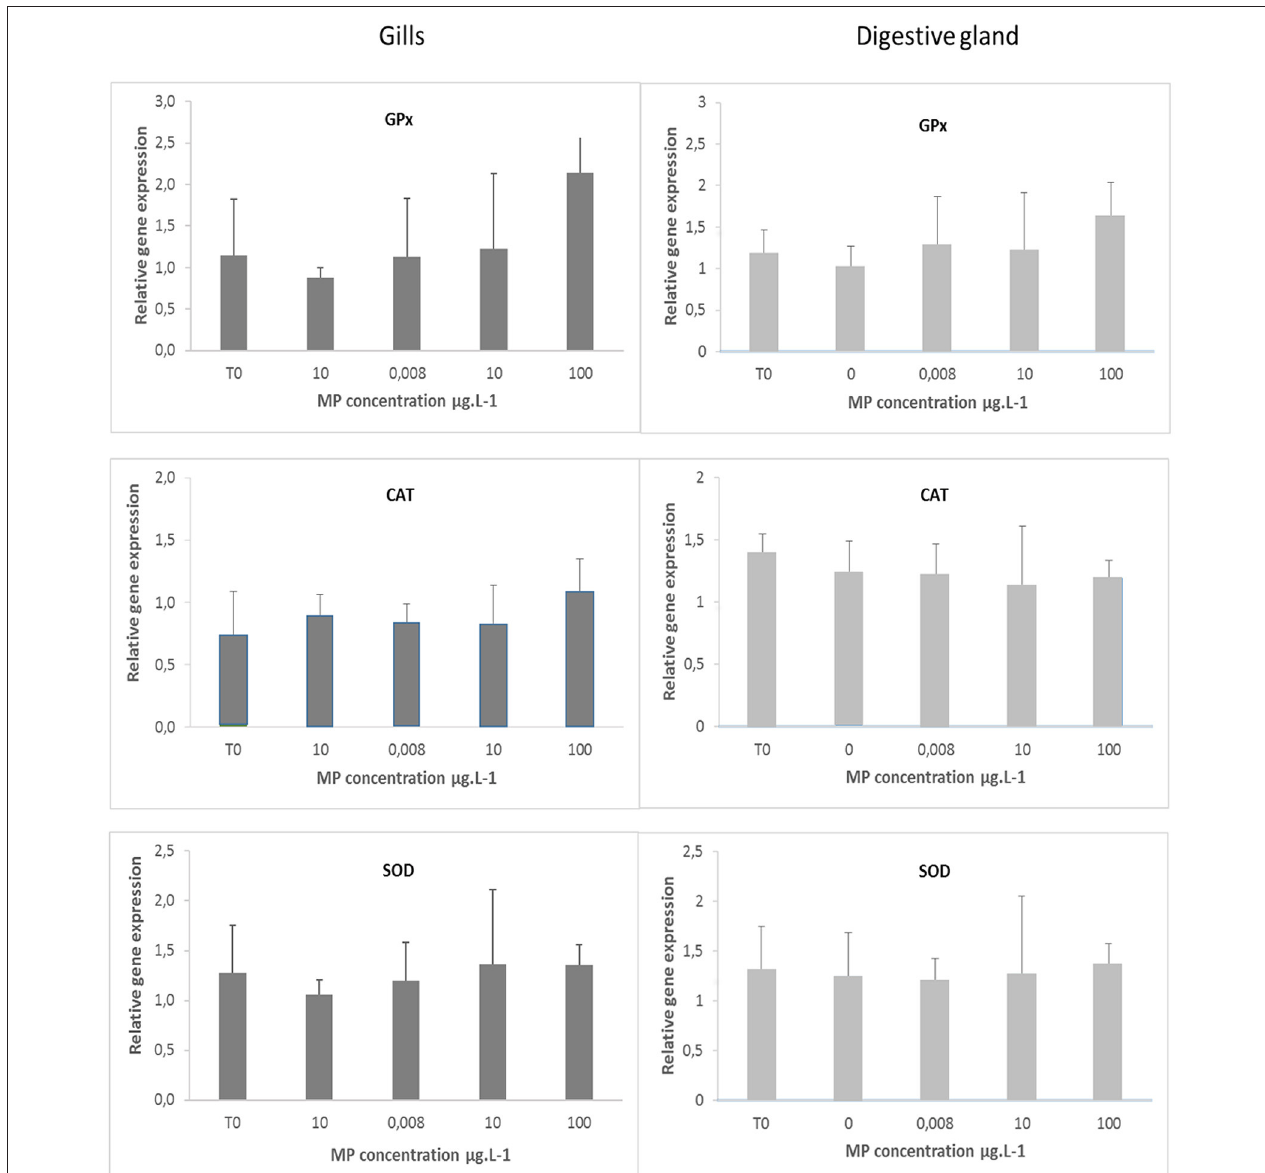
FIGURE 3 | Relative gene expression for GPx, CAT, and SOD in gills and digestive gland of mussels Mytilus spp. at T0 and after 10 days in control mussels (0 MPs L − 1 ) and in mussels exposed to PE and PP microplastics at 0.008, 10, and 100 µ g MPs L − 1 (mean + SD, N = 5).